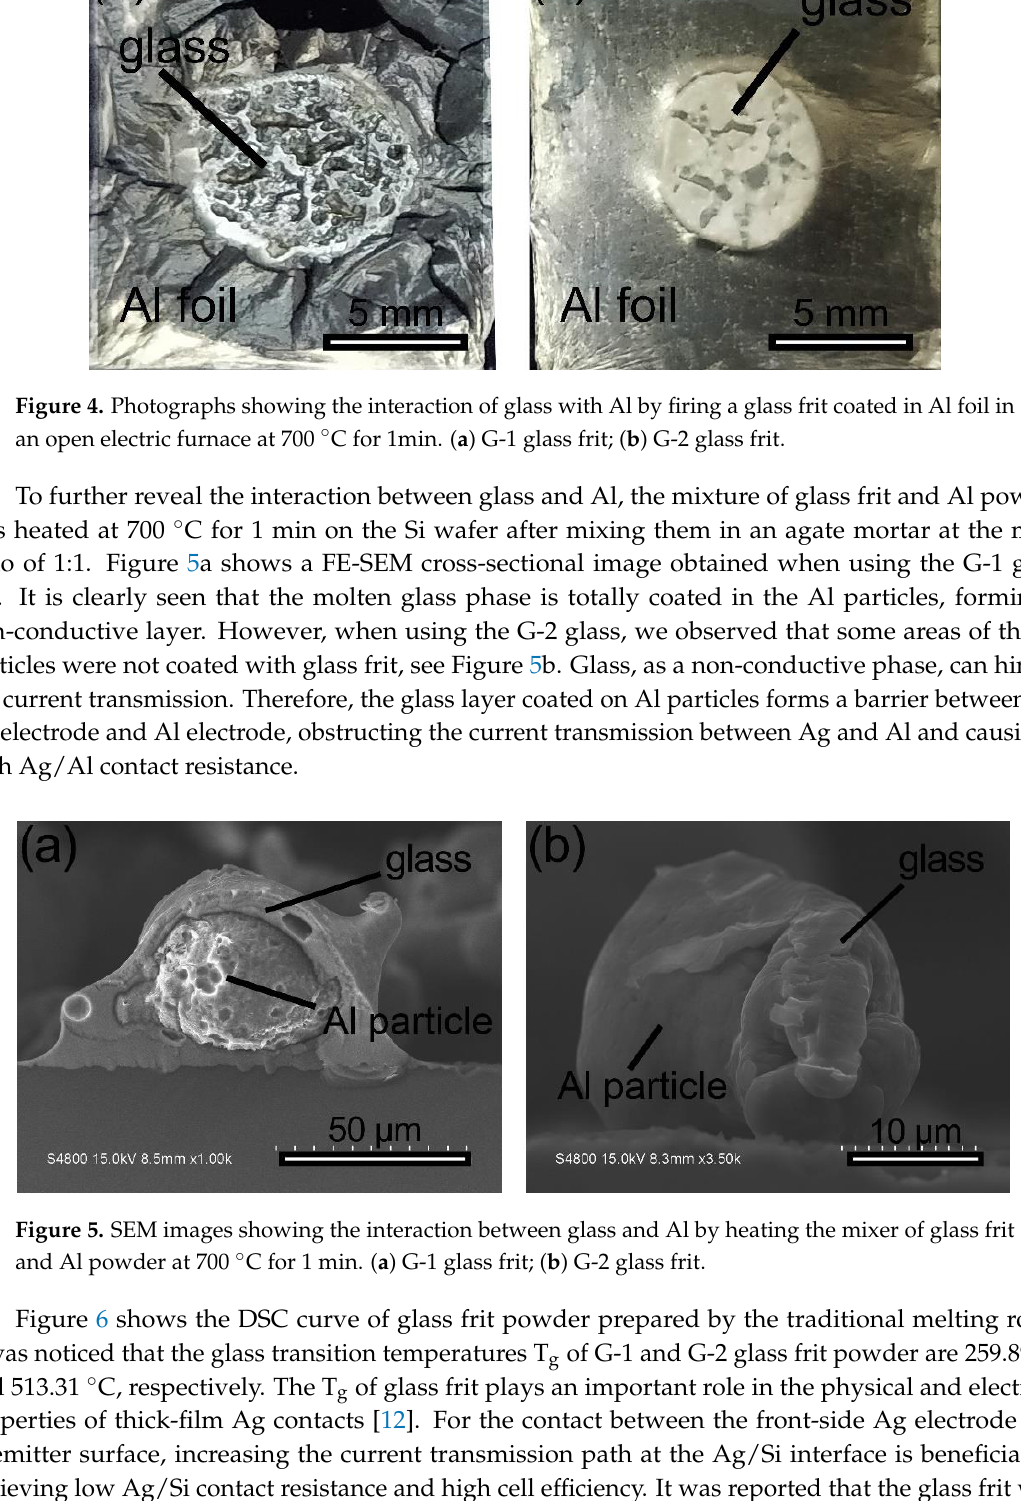
5 of 8 Figure 3. FE-SEM images showing contact interface between Al electrode and Ag electrode. (a1) and (a2): Low and high magnification images for P-1 paste. (b1) and (b2): Low and high magnification images for P-2 paste. To reveal the interaction between glass frit and Al in co-sintering, we investigated the reaction of glass with Al by firing a glass frit coated in Al foil in an open electric furnace at 700 °C for 1 min, as shown in Figure 4. The interaction between G-1 glass frit and Al was evident, and Al foil changed